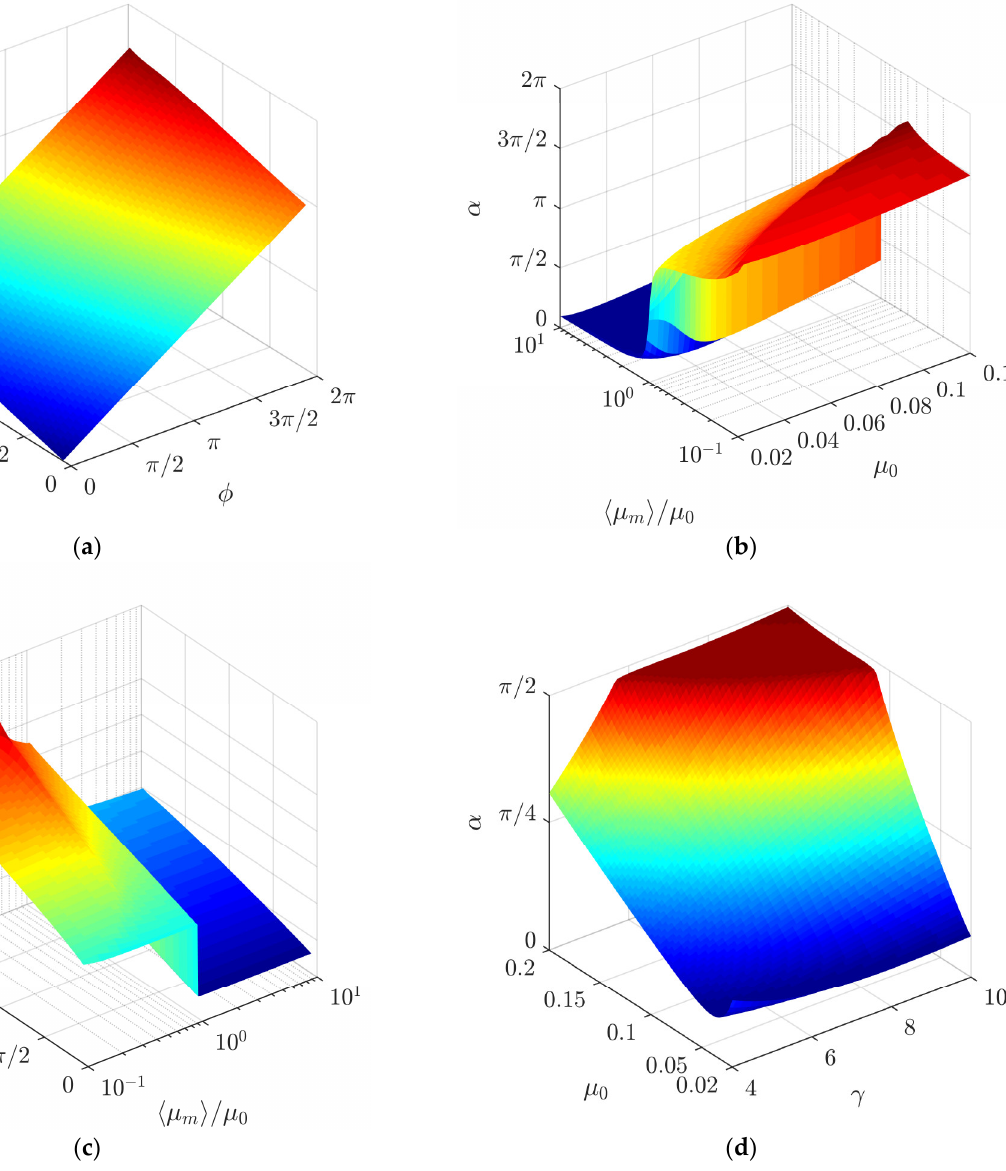
Figure 11. Displacement angle α depending on: ( a ) λ and ϕ when μ 0 = 0.1, γ = 8, ⟨ μ m ⟩ / μ 0 = 0.25; ( b ) ⟨ μ m ⟩ / μ 0 and μ 0 when γ = 5, λ = π , ϕ = 0; ( c ) λ and ⟨ μ m ⟩ / μ 0 when μ 0 = 0.1, γ = 5, ϕ = 0; ( d ) μ 0 and γ when ⟨ μ m ⟩ / μ 0 = 0.25, ϕ = 0, λ = π .